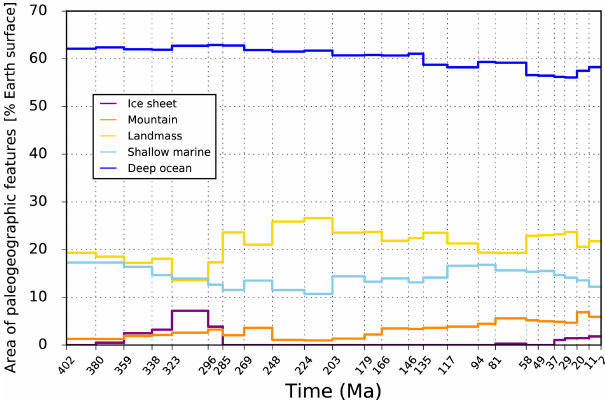
Figure 8. Global paleogeographic feature areas as percentages of Earth’s total surface area estimated from the revised paleogeo- graphic maps from 402Ma to 2Ma.